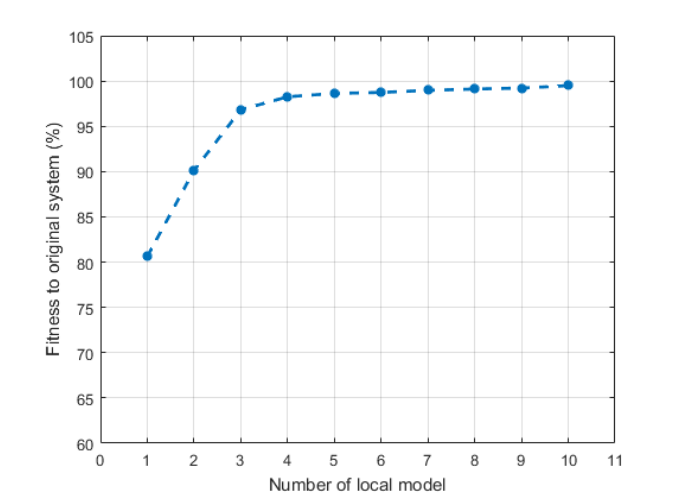
Figure 4. The accuracies of the multiple-model bank with different total numbers of local